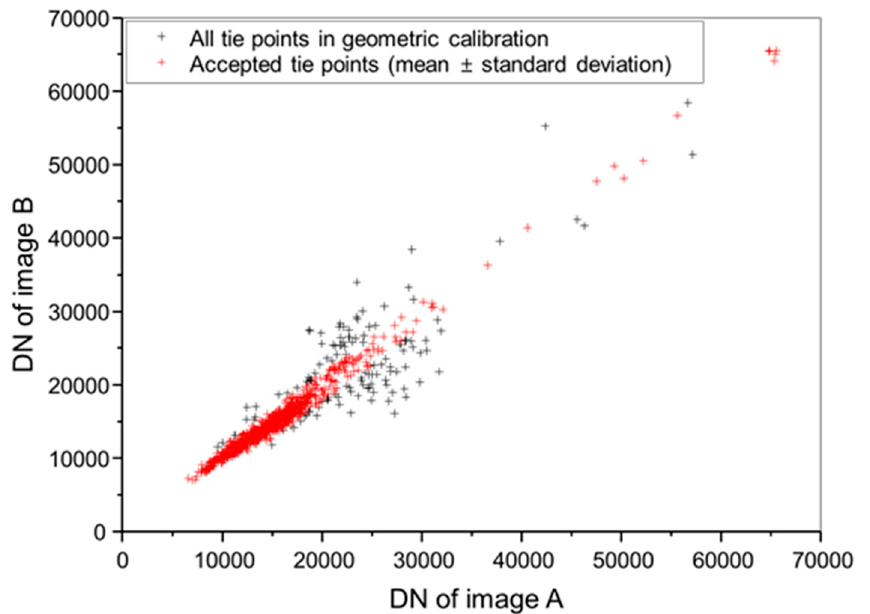
Figure 10. An example of the distribution of digital number (DN) values for all tie points (black crosses) and accepted tie points (red crosses).